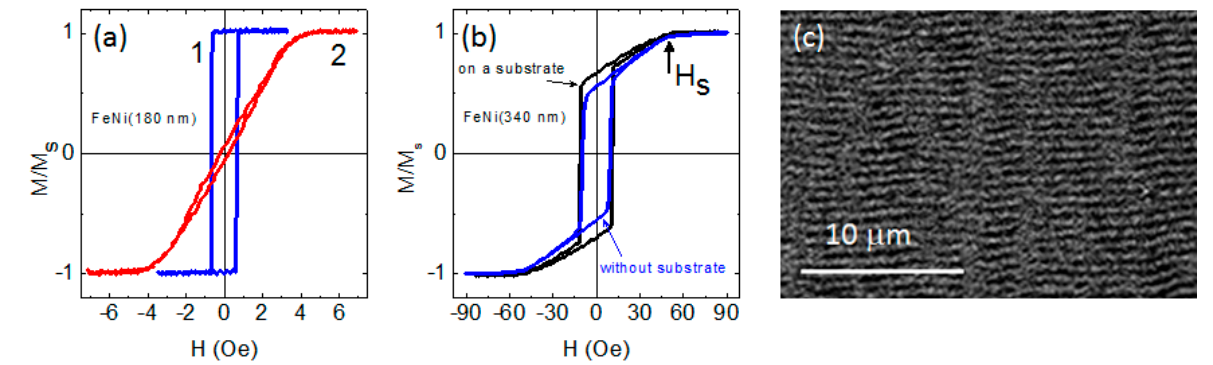
Figure 5. ( a ) hysteresis loops for FeNi(180 nm) film measured along (1) and perpendicular (2) to the easy axis magnetization; ( b ) hysteresis loops for FeNi (340 nm) film both in initial state and after separation from the substrate and annealing at 300 °C during one hour; ( c ) MOKE image of the stripe magnetic domain structure for FeNi (220 nm) film.